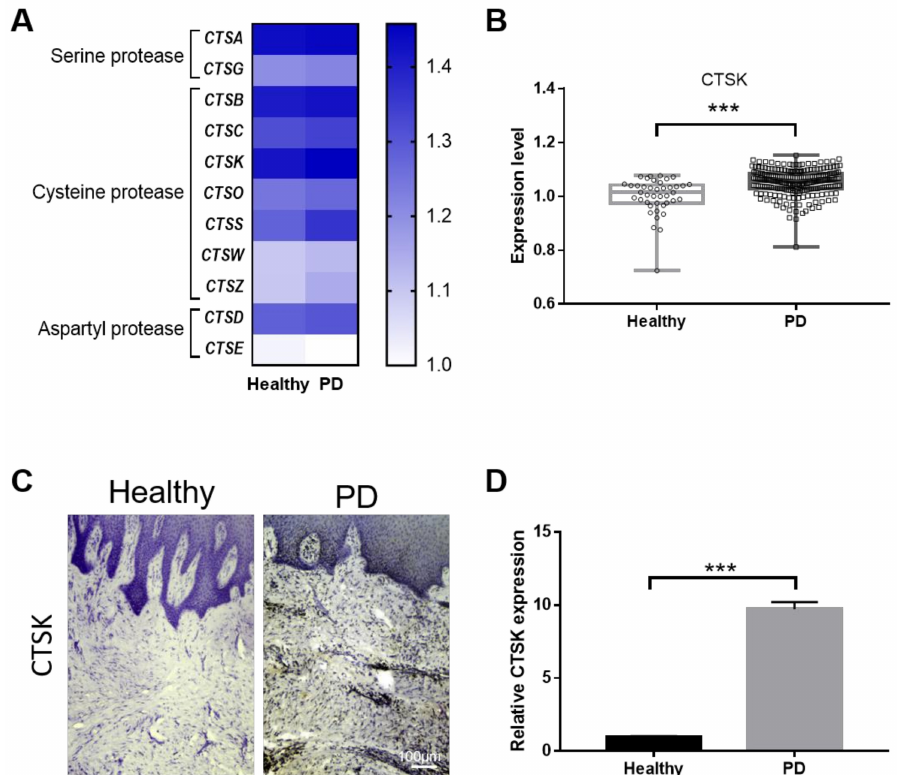
Figure 1. Comparison of cathepsin expression in healthy individuals and patients with peri- odontal disease. ( A ) The expression profiles of the members of the cathepsin family in E-MTAB. ( B ) Comparison of CTSK expression in healthy donors ( n = 76) and patients with periodontal disease ( n = 224). Immunohistochemical analysis ( C ) and mRNA expression ( D ) of CTSK in healthy donors and patients with PD. Data represent the mean ± S.E.M. *** p < 0.001 by Student’s t